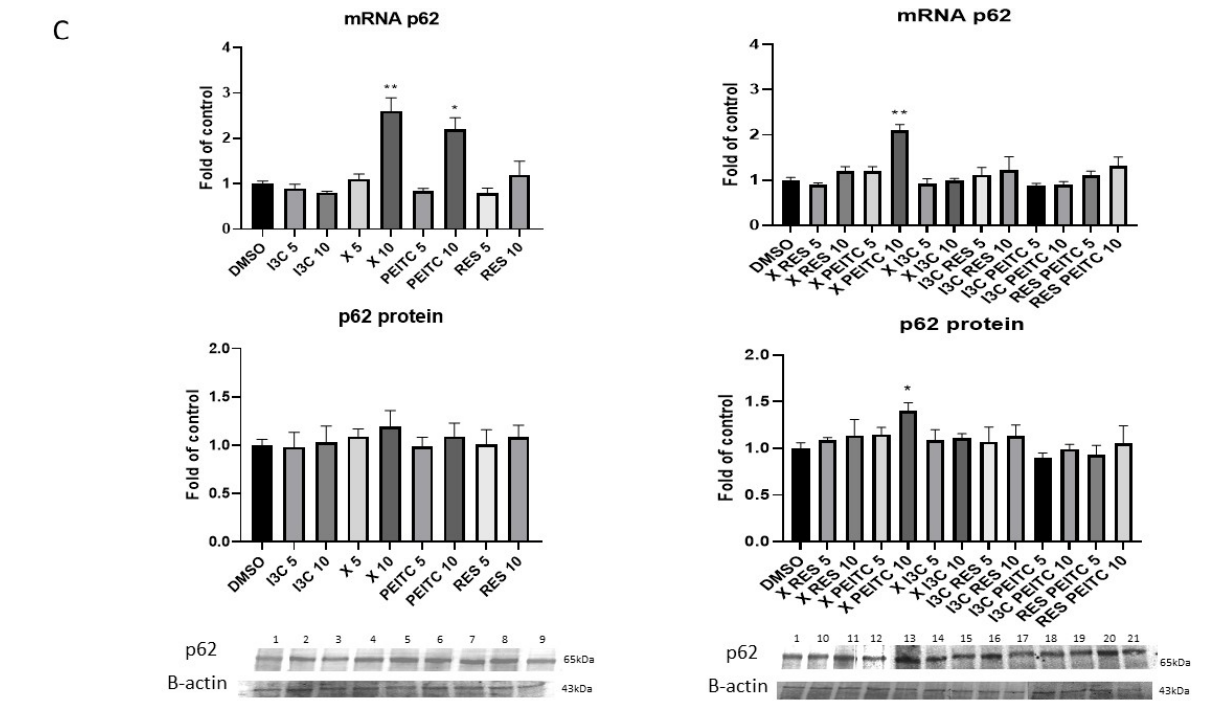
Figure 7. The impact of X, PEITC, RES, I3C, and their mixtures on the expression of Nrf2, Keap1, and p62 in HepG2 cells. Nrf2 (panel A ), Keap1 (panel B ), and p62 (panel C ) expression was calculated as mRNA level in comparison with control cells. Exemplary immunoblots for the analysis of levels of Keap1 (panel B ) and p62 (panel C ) protein. Results of the Western blot analysis are estimated as protein level in comparison with vehicle control. The values are shown as the mean ± SEM calculated from three independent experiments (a fold of control) and determined by one-way ANOVA, post-hoc Dunnet test (* p < 0.05; ** p < 0.01). The asterisk (#) above the bar indicates statistically significant differences between X +PEITC and X or PEITC group, p < 0.05 and p < 0.01. Lane 1, cells treated with DMSO; lane 2, I3C 5 µ M; lane 3, I3C 10 µ M; lane 4,